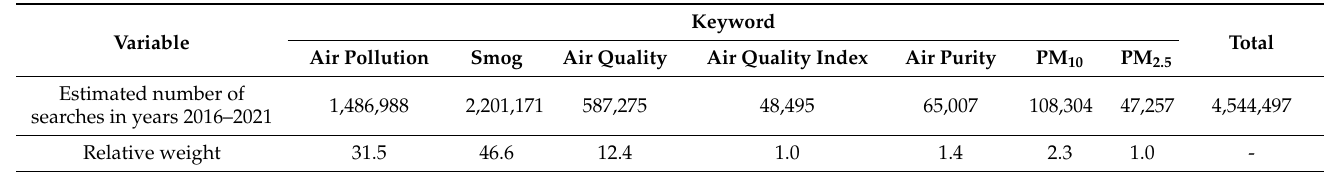
Table 1. Estimated keyword search volumes.